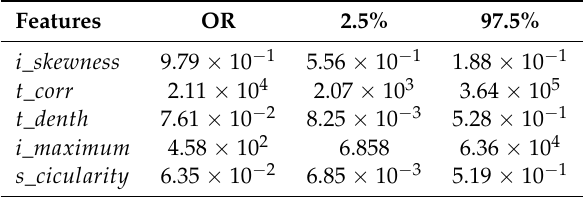
Table 3. OR values from the model obtained by K-NN method.